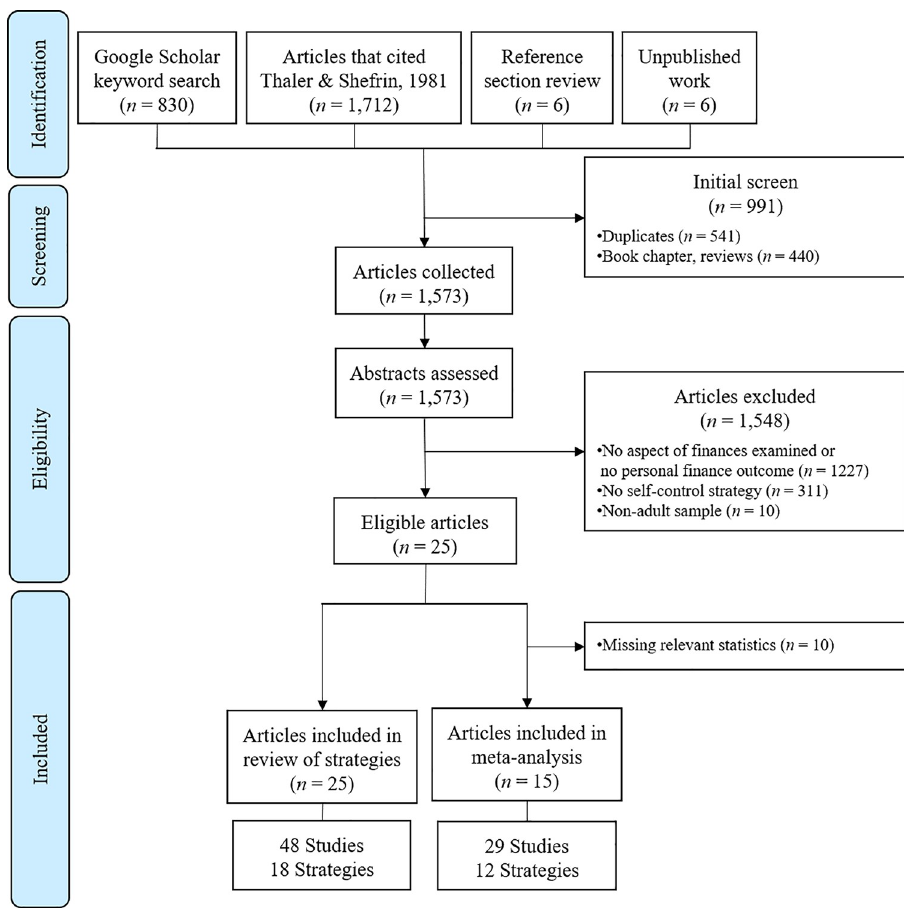
Fig 1. Flow diagram of screening